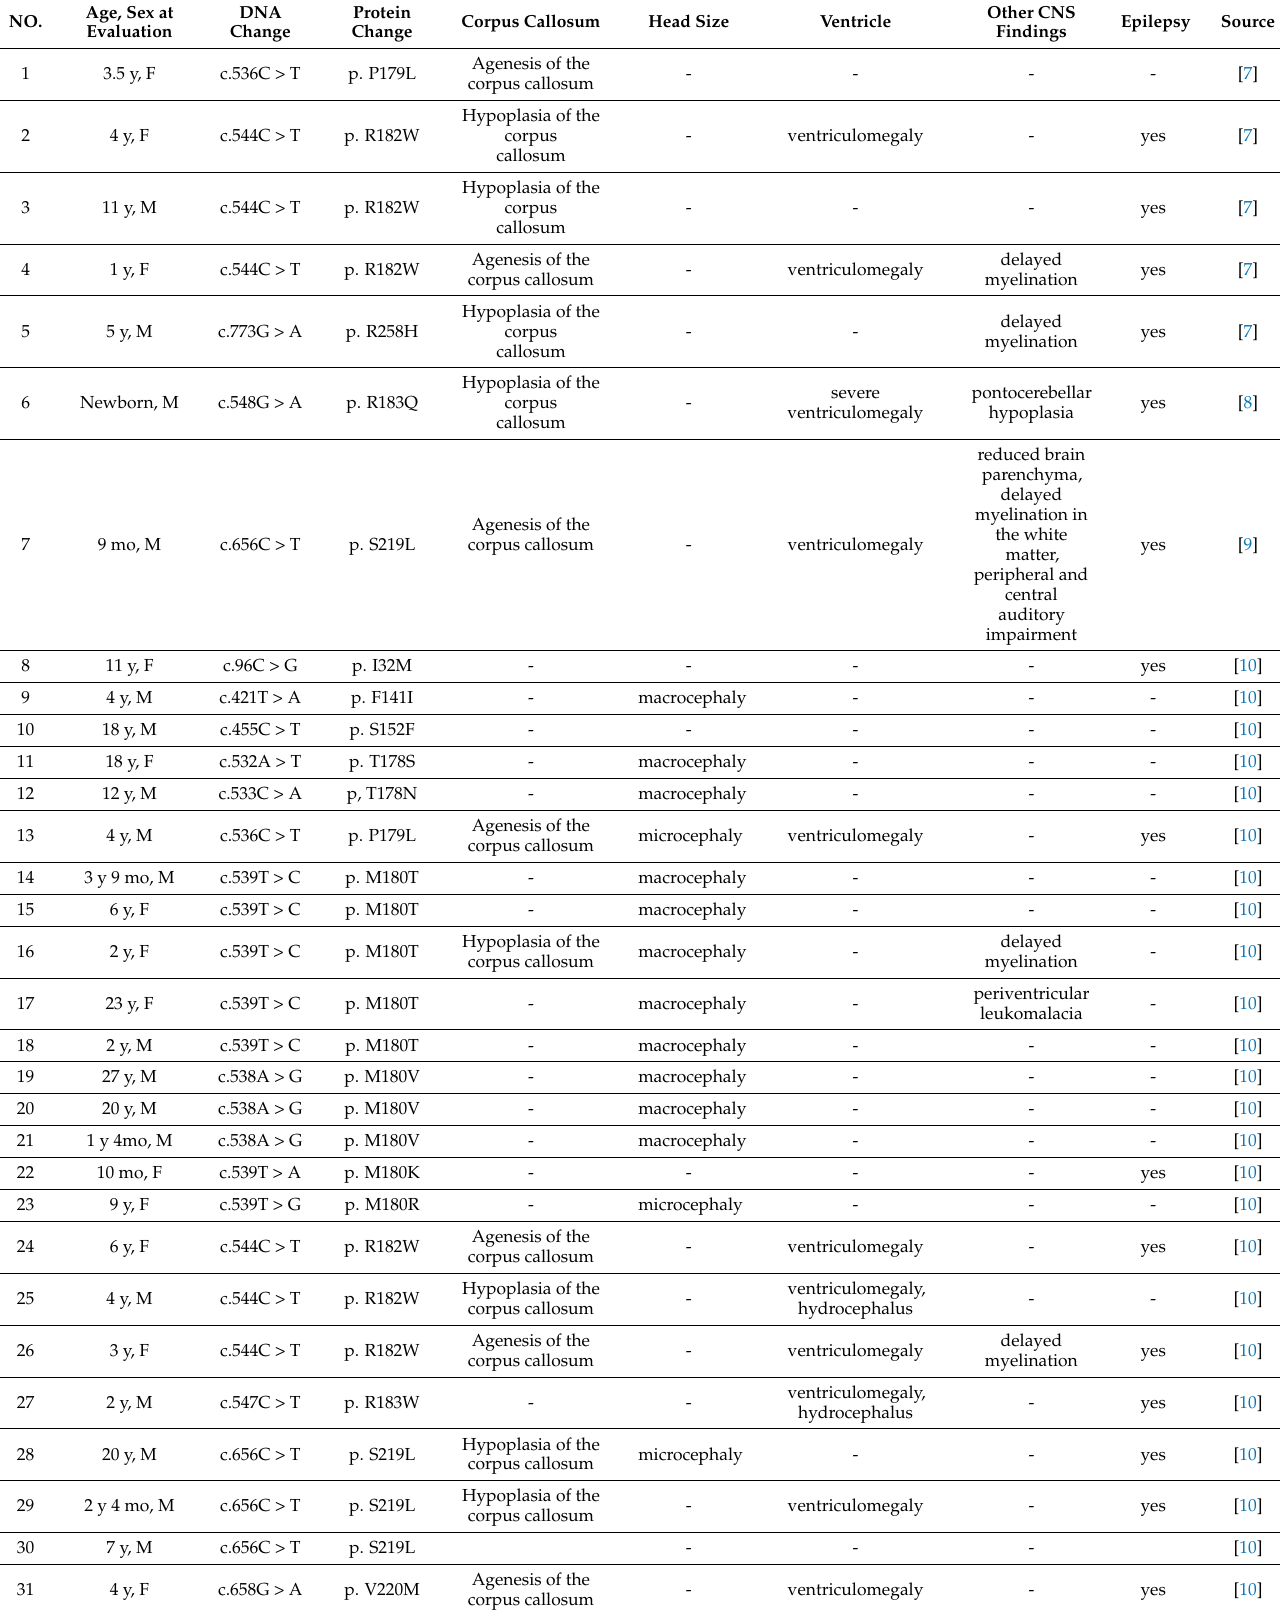
Table 1. Reports of abnormal CNS findings in patients with